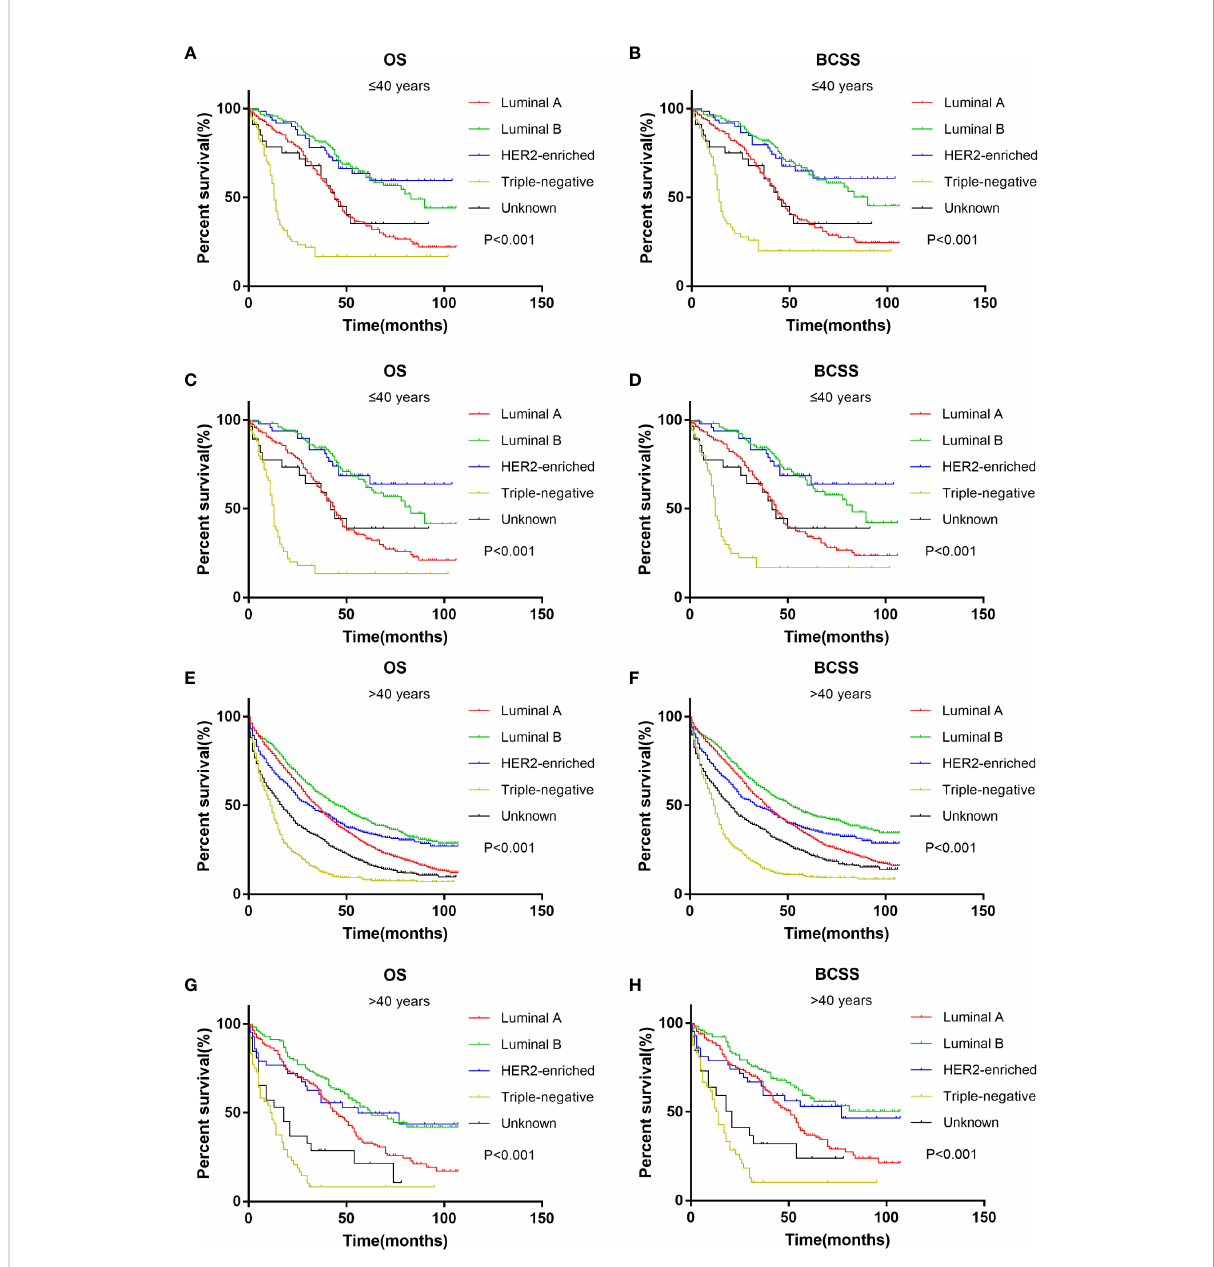
FIGURE 4 Kaplan-Meier curve of overall survival and cancer-speci fi c survival according to BC subtype in younger ( ≤ 40 years) groups before (A, B) and after (C, D) PSM; Kaplan-Meier curve of overall survival and cancer-speci fi c survival according to BC subtype in older (>40 years) groups before (E, F) and after (G, H)